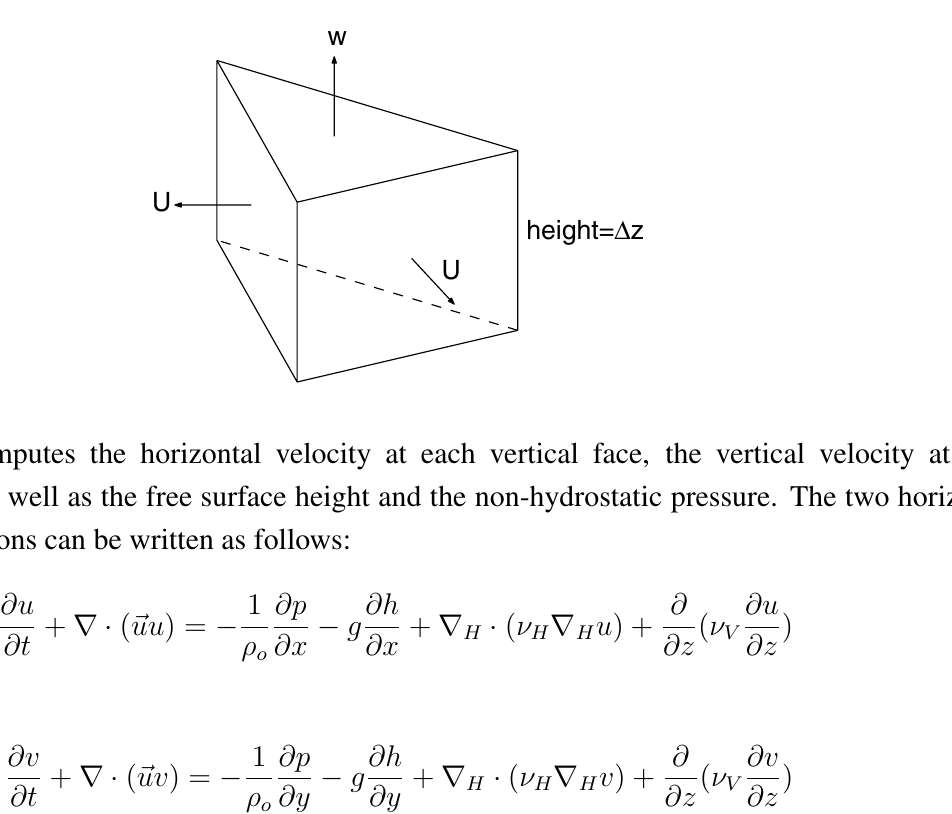
Figure 2. Description of a 3D prismatic grid cell.